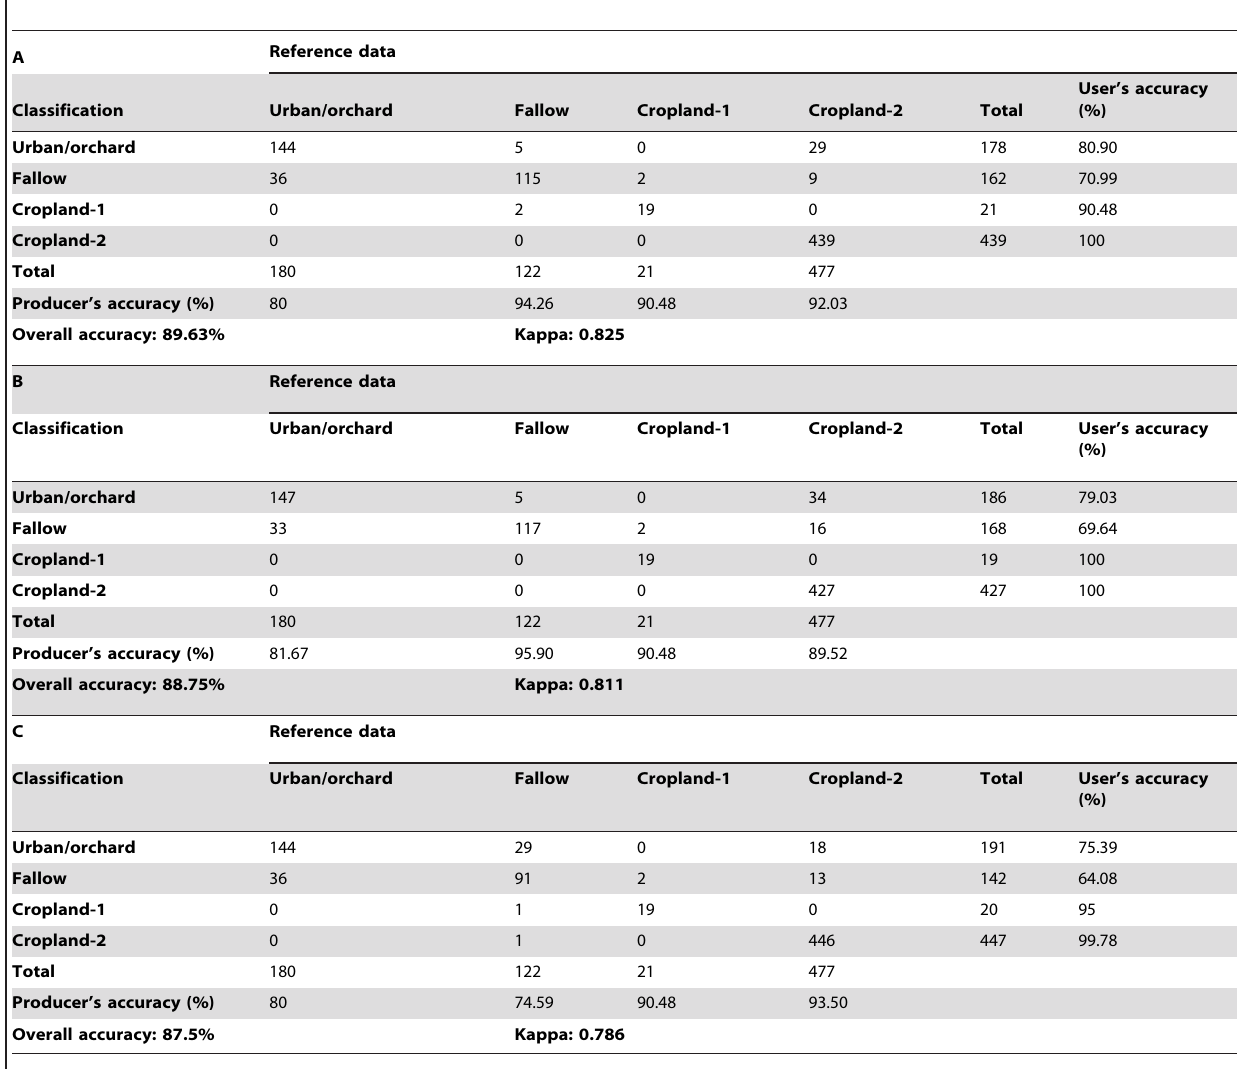
Table 4. Land classification accuracy assessments of data processed by different smoothing methods (A) asymmetric